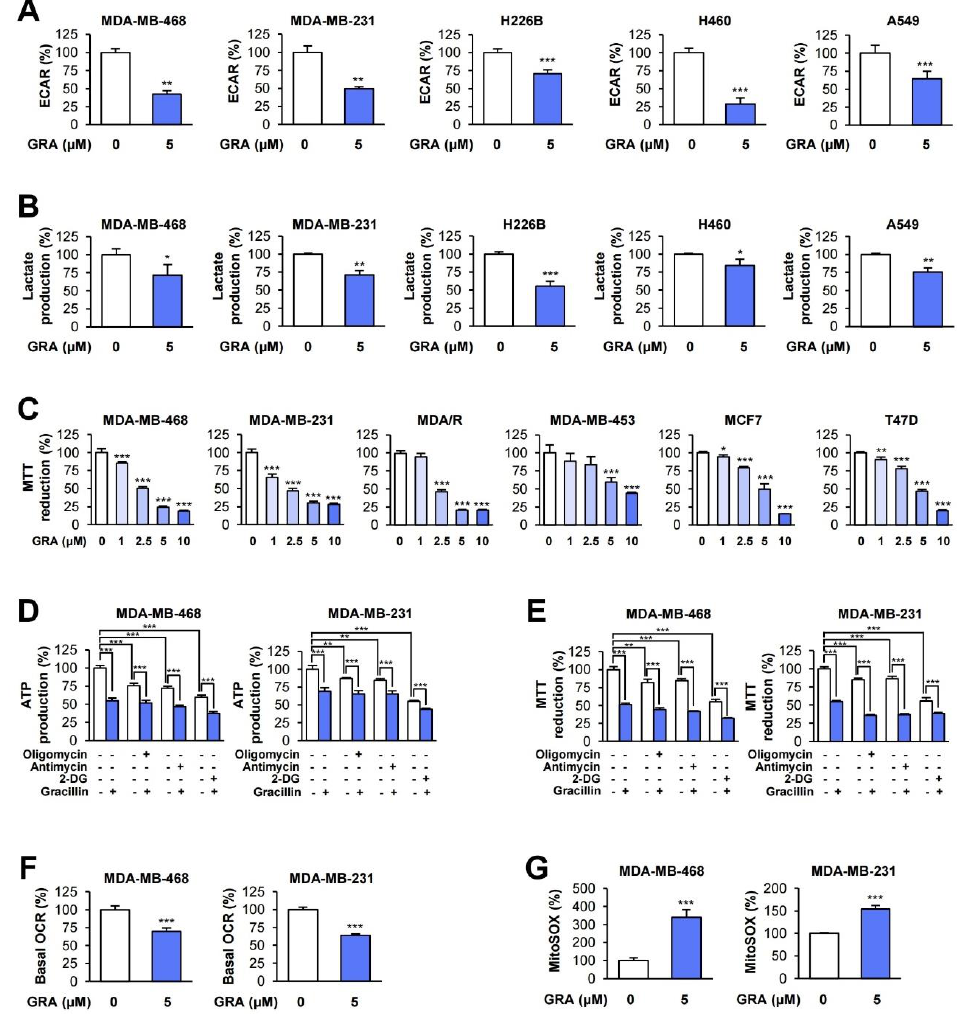
Figure 2. Inhibitory effect of gracillin on glycolysis and OXPHOS. ( A – F ) The effect of gracillin on basal extracellular acidification rate (ECAR) ( A ) and oxygen consumption rate (OCR) ( F ) was determined by using a Seahorse XF analyzer. ( B ) The inhibitory effect of gracillin on lactate production in lung and breast cancer cells was determined using a commercially available kit. ( C ) The 3-(4,5-dimethylthiazol-2-yl)-2,5-diphenyltetrazolium bromide (MTT) assay was performed to determine the effect of gracillin on dehydrogenase activity in mitochondria in breast cancer cells. Cells were treated with increasing concentrations of gracillin for three days. ( D , E ) Triple-negative breast cancer (TNBC) cells were treated with oligomycin (5 µ M), antimycin (10 µ M), or 2-deoxy-D-glucose (2-DG; 25 mM) alone or in combination with gracillin (5 µ M) for 6 h. The levels of adenosine triphosphate (ATP) production ( D ) and the MTT reduction ( E ) were determined as described in Materials and Methods. ( G ) The upregulation of mitochondrial reactive oxygen species (ROS) by treatment with gracillin was determined using the fluorescent probe MitoSOX as described in Materials and Methods. The bars represent the mean ± SD; * p < 0.05, ** p < 0.01, and *** p < 0.001, as determined by a two-tailed Student’s t -test by comparison with the indicated group ( D , E ) or vehicle-treated control group ( A – C , F , G ). Con: control; GRA: 2.2. Gracillin Inhibits the Viability of Human Breast Cancer Cells by Inducing Apoptosis